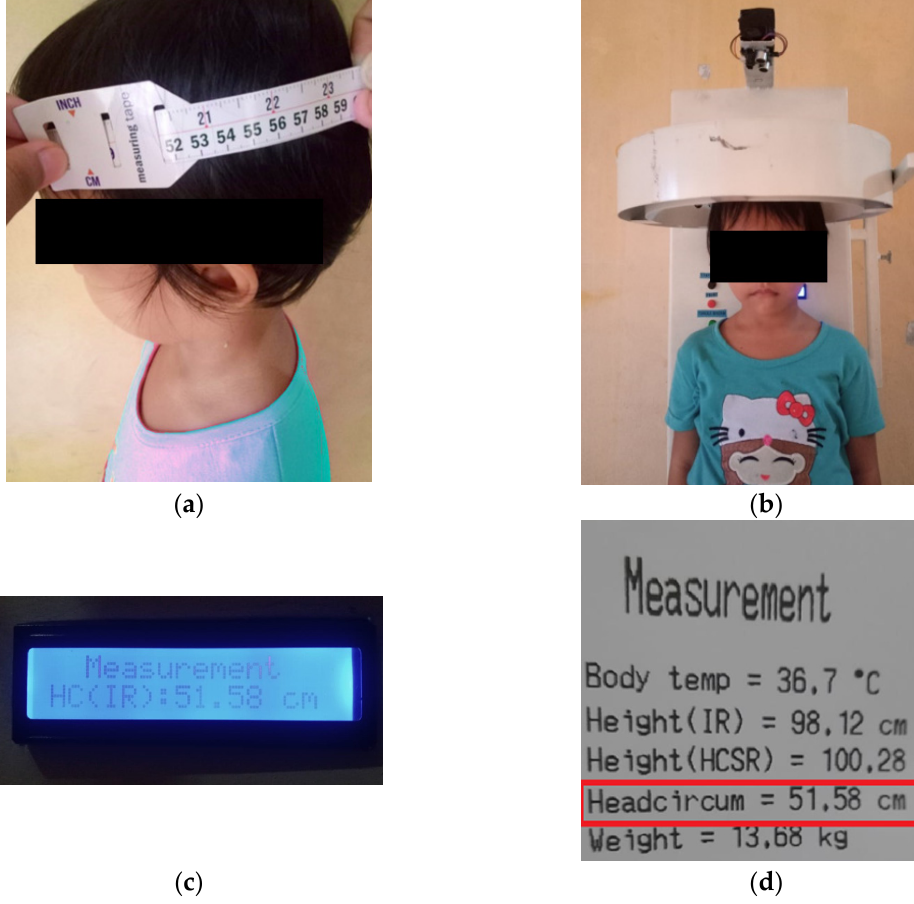
Figure 13. Head circumference measurement tests ( a ) using the commercial device; ( b ) using anthropometric prototype; ( c ) display of height measurement on LCD 6 × 2; and ( d ) printer output. The measurement results for the five participants were carried out using a measuring tape as a con-